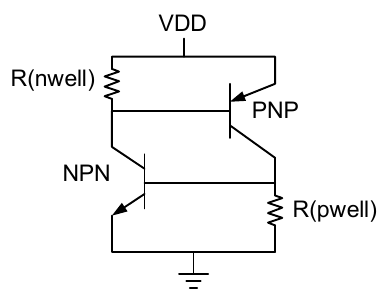
Figure 4. Parasitic transistor [5].